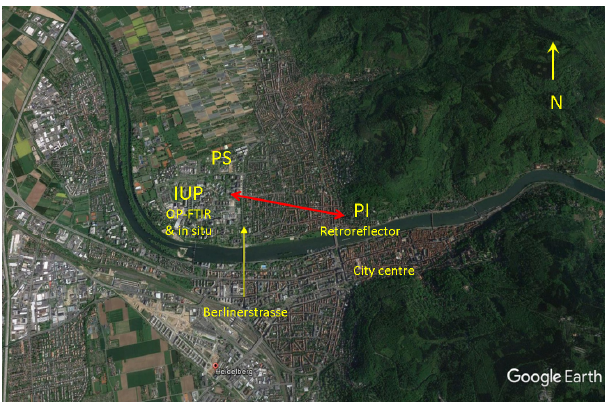
Figure 3. Typical NIR long path spectrum, recorded 1 Octo- ber